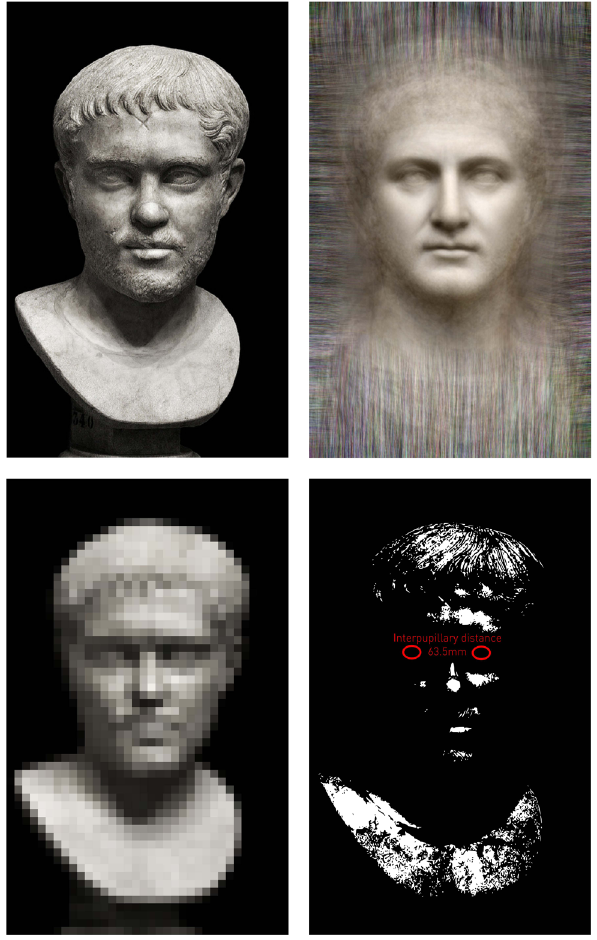
Figure 1. Dimensionality and individualisation. The face of the Roman Emperor Hostilian (top left) is poorly described by the canonical face of all Roman Emperors (top right), which is—by definition—not identical with any of the individual faces from which it is derived. Furthermore, the individuality of a face is better captured by a low-precision, high-dimensional parameterisation (bottom left), than it is by a high-precision, low-dimensional parameterisation such as the inter-pupillary distance (bottom right). The photograph of Hostilian is reproduced with the kind permission of Dr William